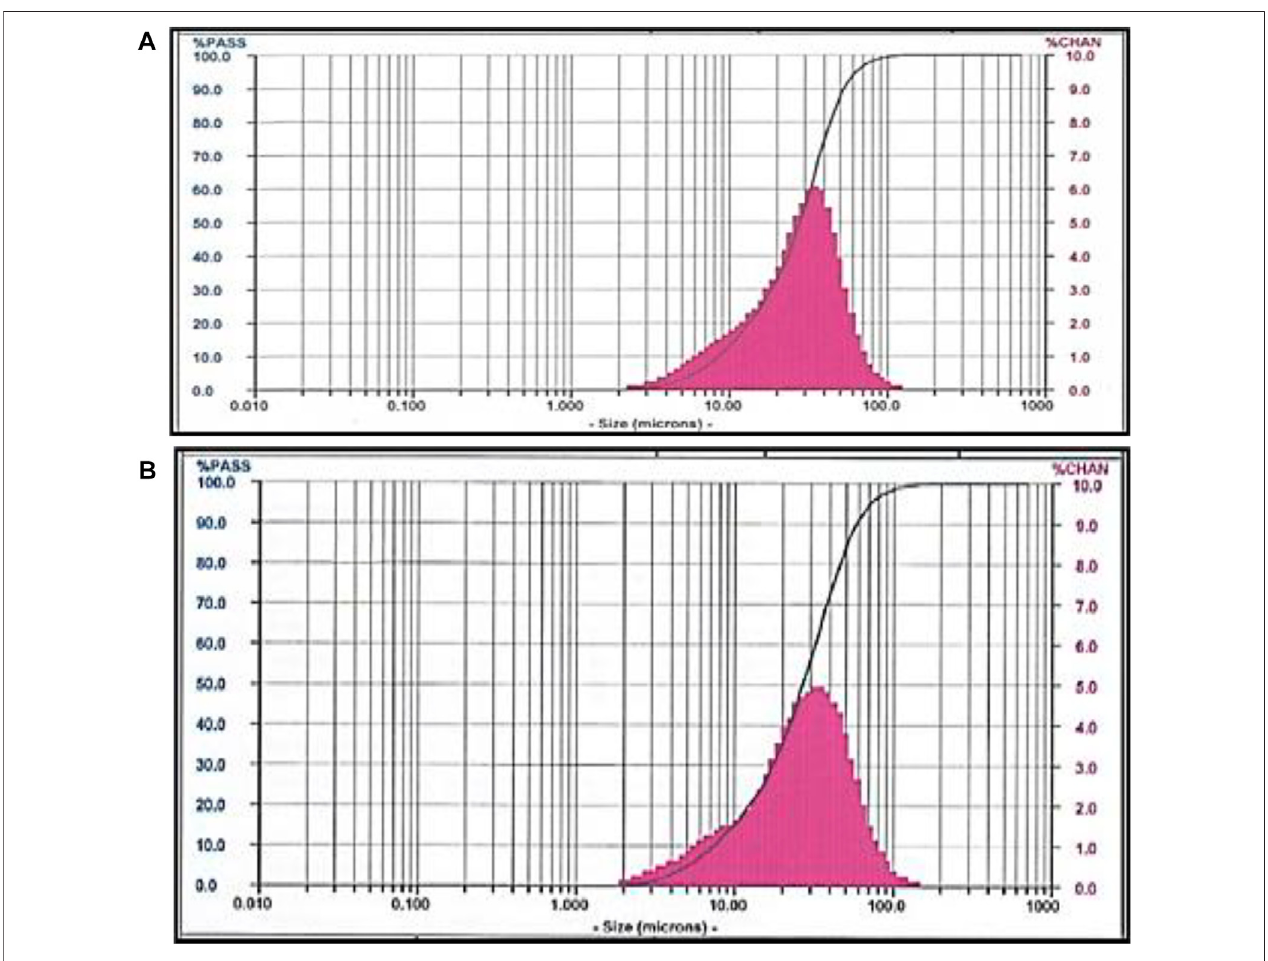
FIGURE 2 | PSD analysis for (A) 45 and (B) 75 µm of